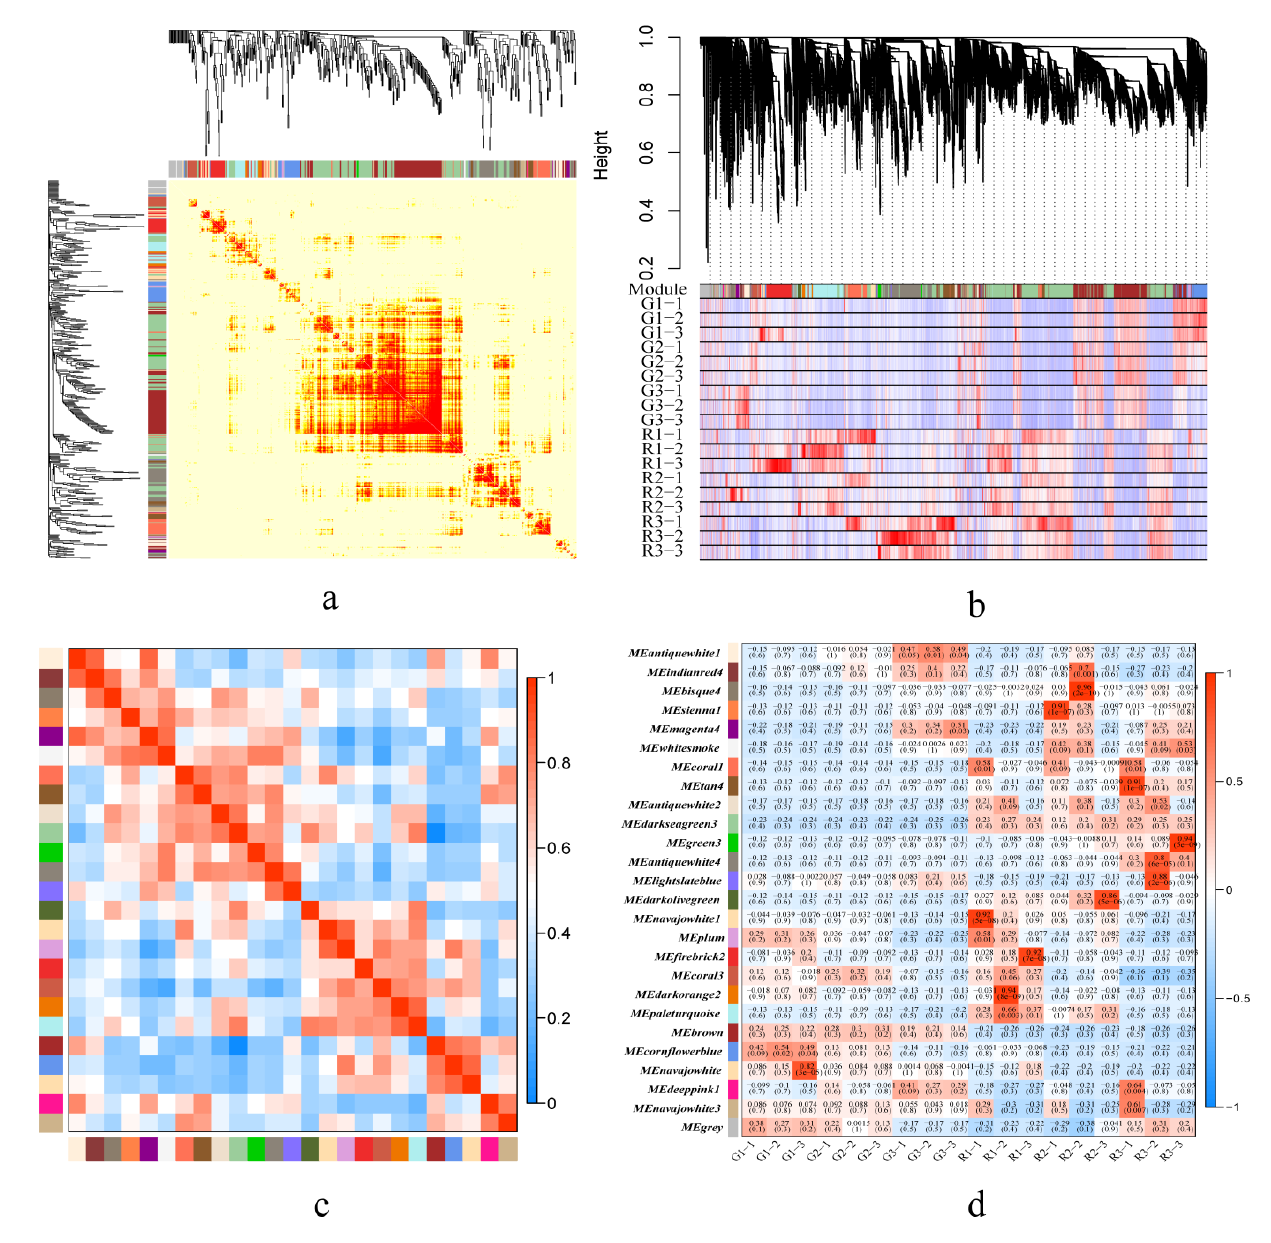
Figure 4. Weighted gene co-expression network analysis. ( a ) Network heatmap plot. ( b ) Cluster dendrogram. ( c ) Eigengene adjacency heat map. ( d ) Module-trait relationships (upper values are the correlation coefficients, and lower values are the p -values).